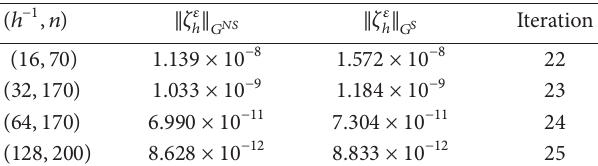
Table 2: The order of convergence in the “singular” part when ℎ = 2 −󰜚 and 𝜀 = 5 × 10 −13 . (2 −󰜚 ,𝑛) ‖𝜁 𝜀 (2 −4 ,100) 1.931 × 10 −8 16.078 (2 −5 ,150) 1.182 × 10 −9 (2 −7 ,130) 1.315 × 10 −11